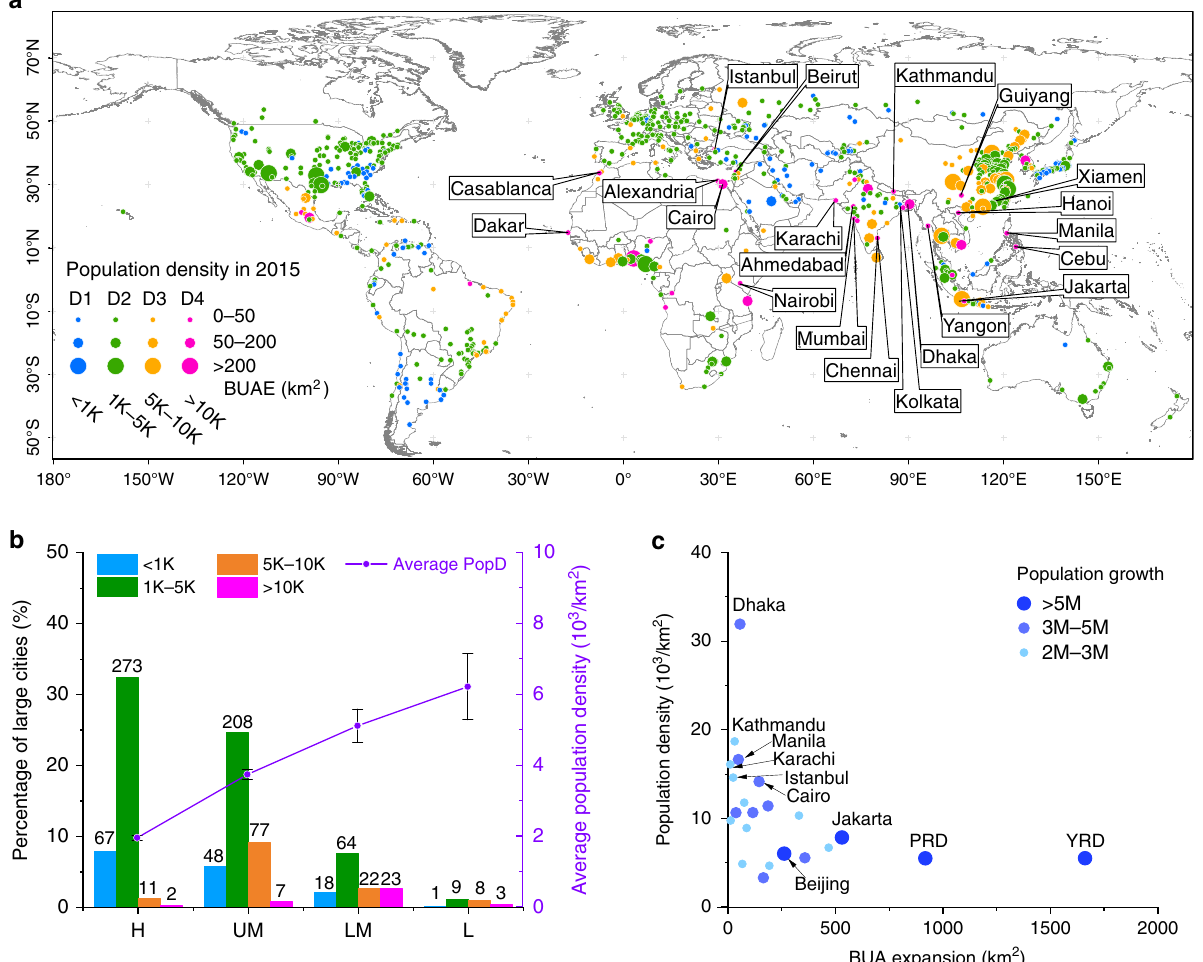
Fig. 2 Distribution of large cities with the population density. a Distribution of the 841 large cities at four different levels of the population density (PopD, unit: 1/km 2 ) in 2015. D1: 0 < PopD ≤ 1K, blue points; D2: 1K < PopD ≤ 5K, green points; D3: 5K < PopD ≤ 10K, orange points; D4: PopD > 10K, magenta points. b Bars are the percentages of the 841 large cities for four PopD levels in 2015 at four economic levels. Error bars show SEM for each economic level. c Relationship between PopD in 2015 and the BUA expansion from 2001 to 2018 of the 22 large cities with population growth larger than 2M. YRD Yangtze River Delta, PRD Pearl River Delta. The size of the dots refers to the population growth at different